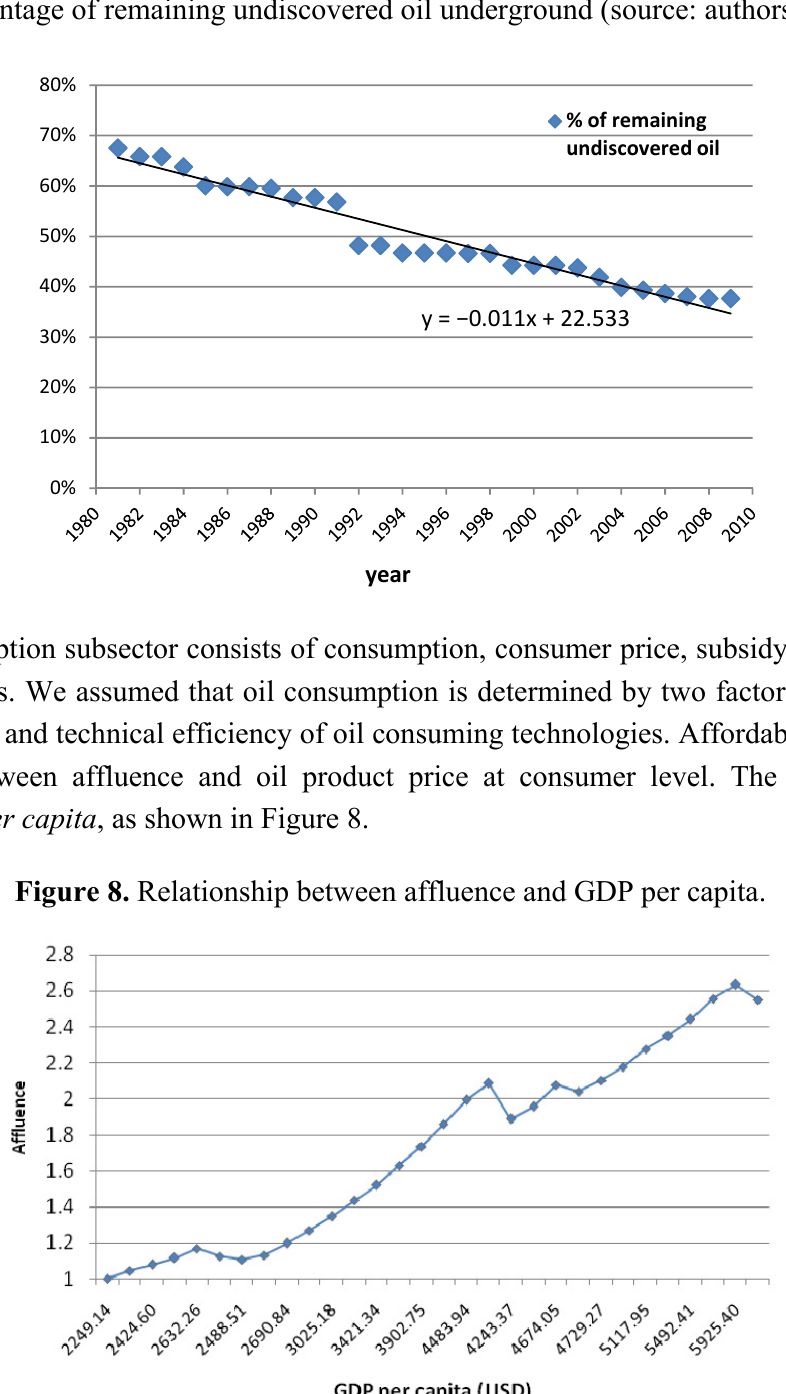
Figure 7. Percentage of remaining undiscovered oil underground (source: authors’ calculations).